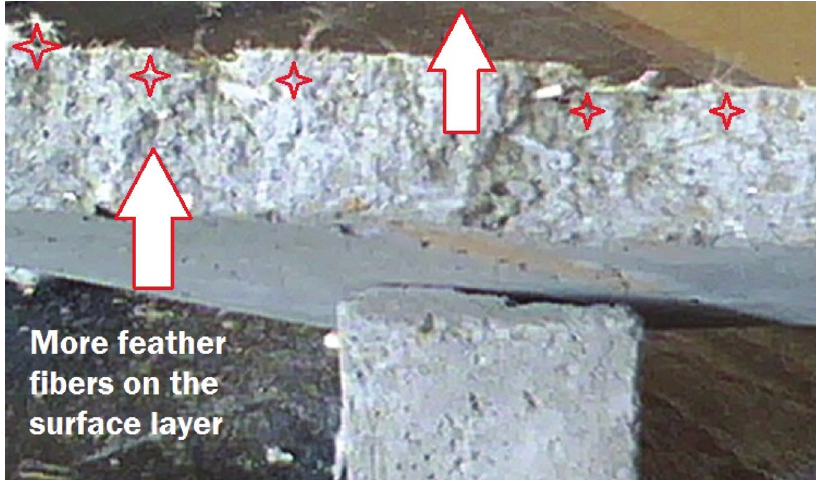
Figure 9 A cross-sectional examination of the mortar cubes confirmed the presence of more feather fibers on the surface